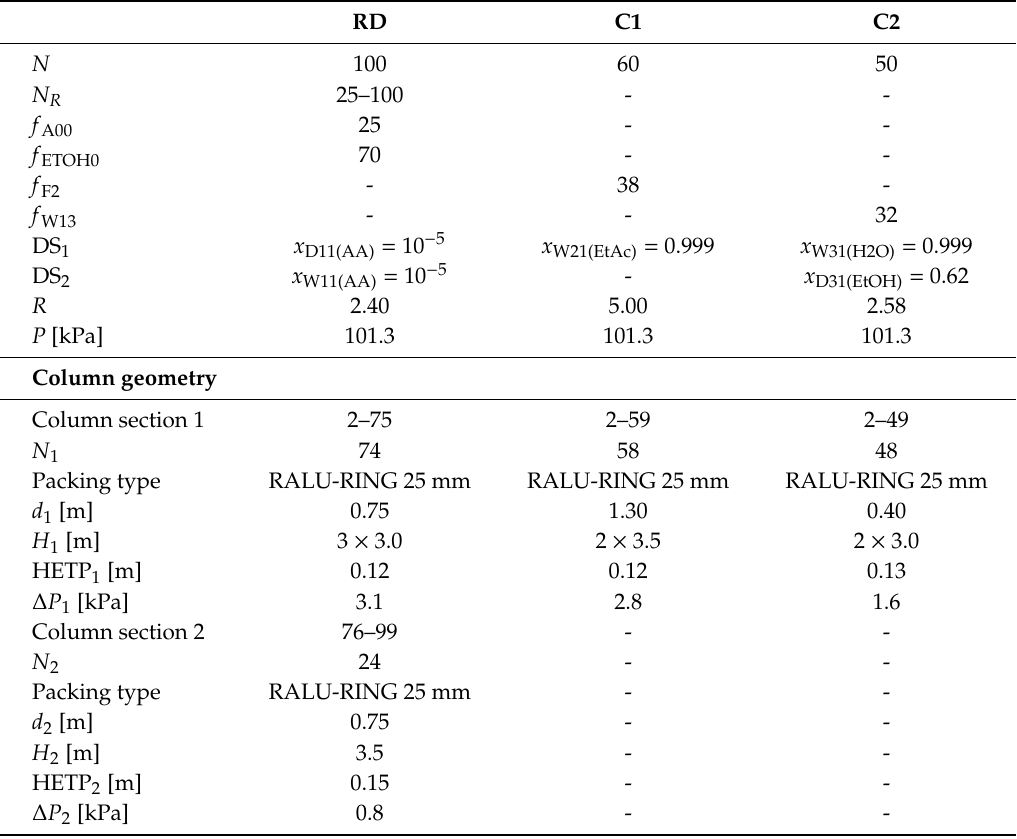
Table 4. Parameters of designed columns—reactive distillation (RD) column with a separation unit (Figure